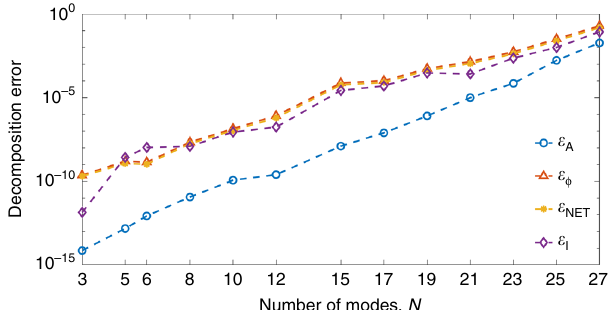
Fig. 2 Noiseless decomposition errors. Dependence of the amplitude, phase, net and intensity errors on the number of modes in the absence of noise. Here ε A — amplitude error, ε φ — phase error, ε NET — total error, and ε I — intensity error. Source data are provided as a Source Data fi